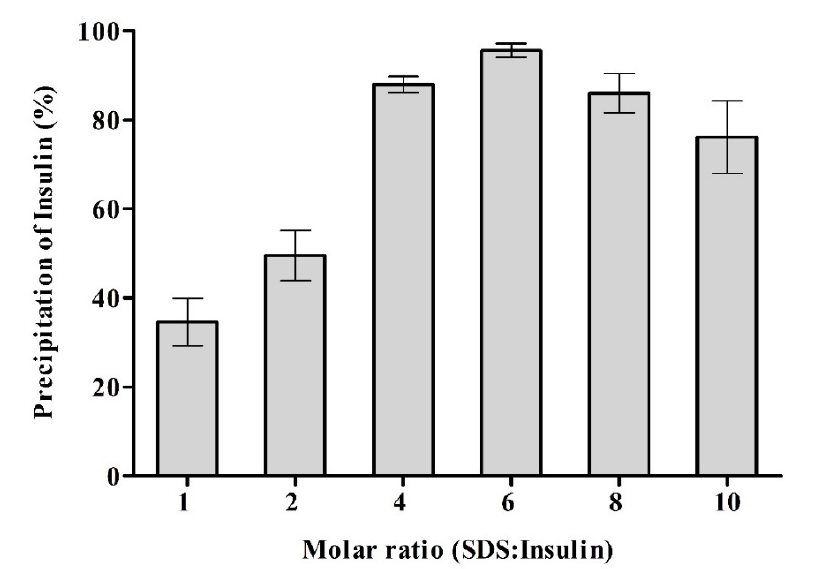
Figure 1. Precipitation efficiency of INS with indicated molar ratios of sodium dodecyl sulfate (SDS). A total of 1 mM INS solution in 0.01 M HCl was mixed with aqueous SDS solution at indicated molar ratios. Resulting INS-SDS complexes were obtained as precipitates that were separated by centrifugation. The remaining free INS present in the supernatant was quantified via HPLC to calculate precipitation efficiency at each molar ratio. Data are shown as means ± SD ( n = 3).